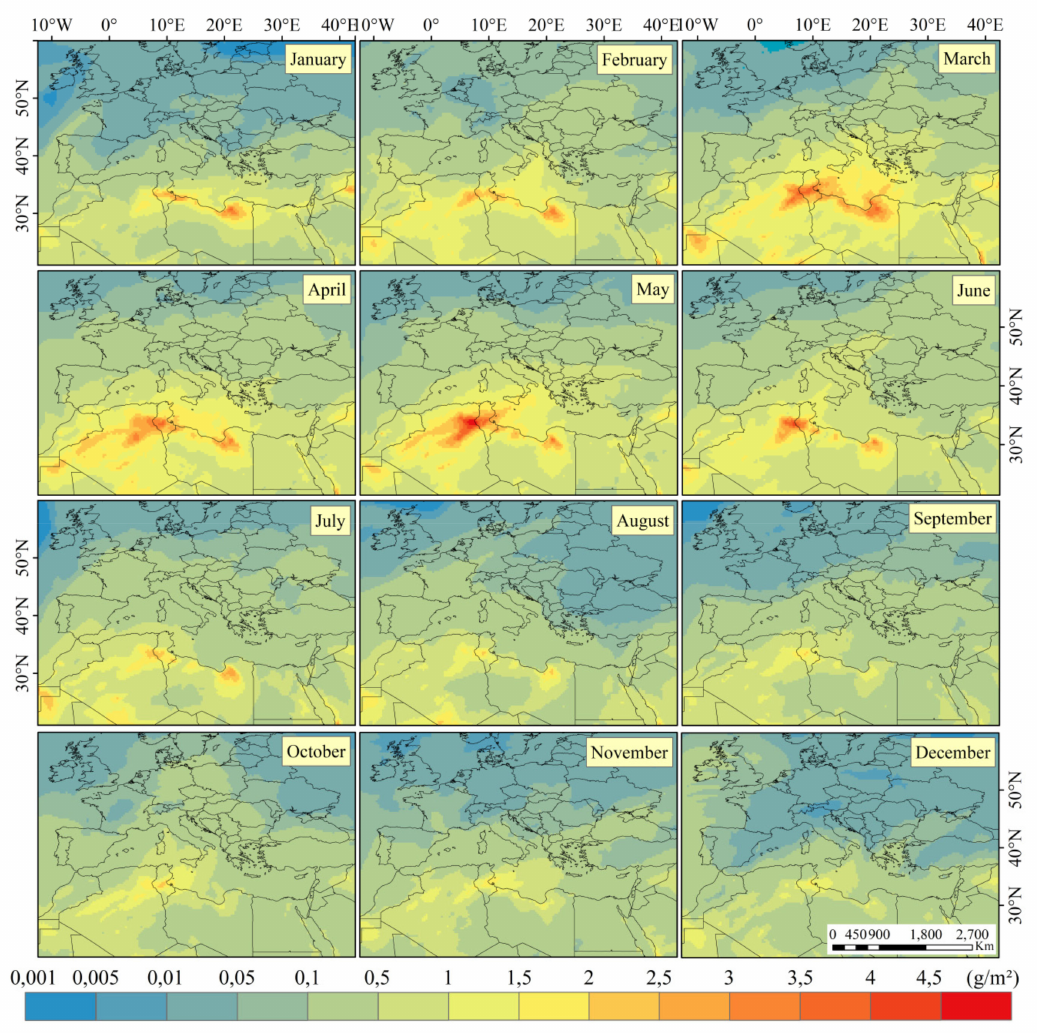
Figure 3. Spatial distribution of the monthly mean maximum DL (December 2015–February